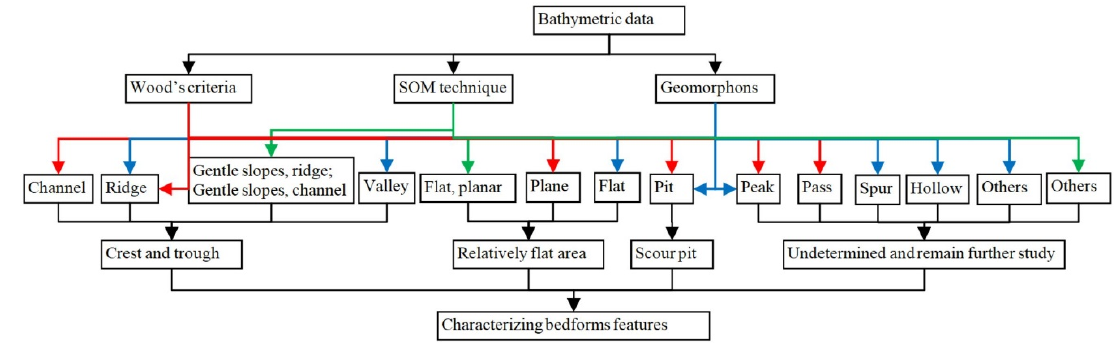
Figure 9. Strategy for describing subaqueous bedforms features using geomorphic elements in a river system.